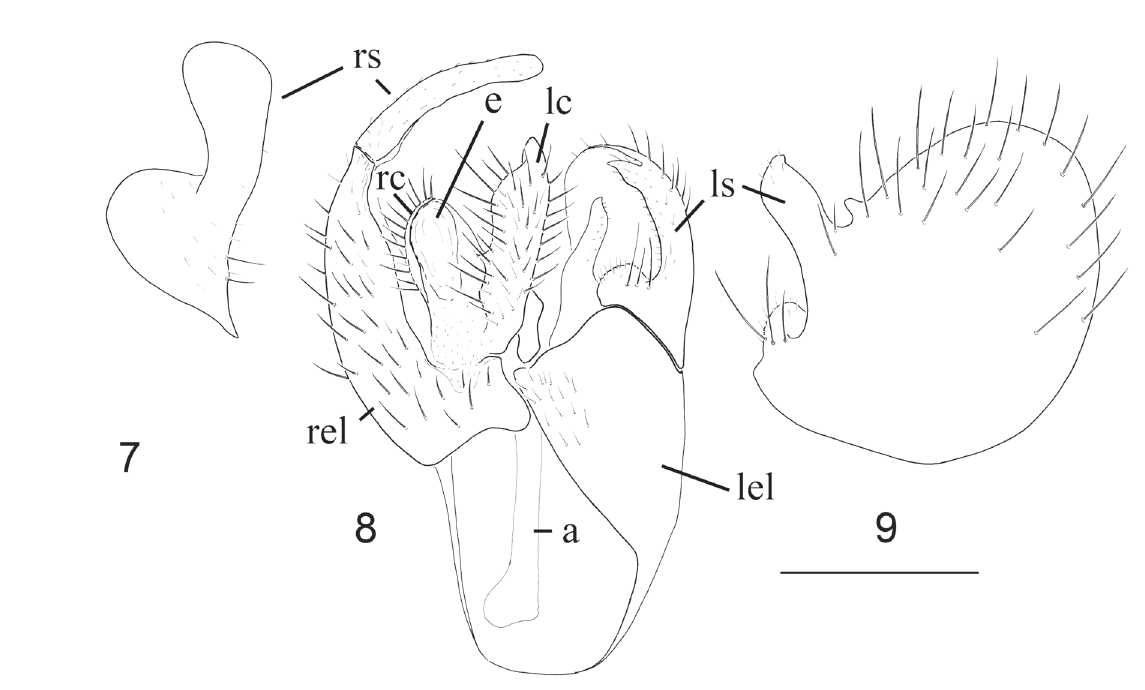
Figs 7-9. Elaphropeza biuncinata (Melander, 1928). 7 . right surstylus. 8 . epandrium with cerci. 9 . left surstylus. a: ejaculatory apodeme; e = epiproct; lel = left epandrial lamella; lc = left cercus; rc = right cercus; rs = right surstylus. Scale bar= 0.1